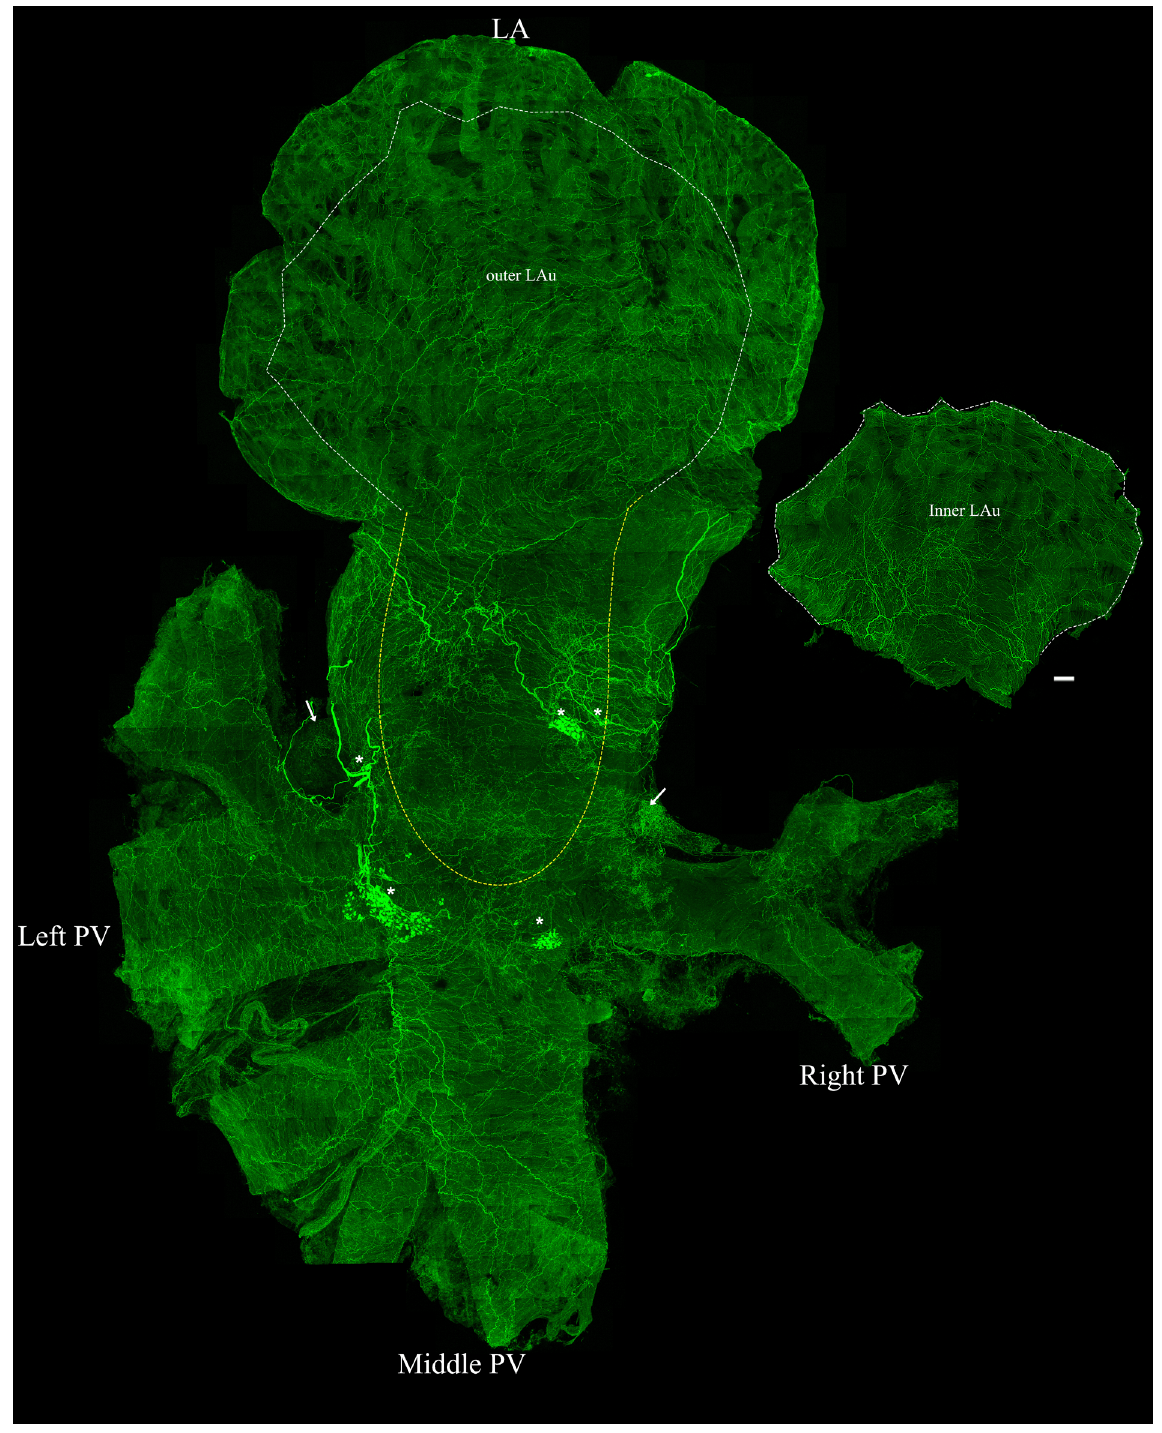
Figure 8. TH-IR axons in the LA of a representative mouse. The LA was separated from the RA of the same representative mouse in Fig. 4. A montage of ~ 700 maximal projections in the LA showed that large TH-IR bundles entered the atrium at the LA-PV junction, traveled through cardiac ganglia, branched out to smaller axon bundles and extended individual axons that innervated the whole atrium with dense terminal varicosities. (Please zoom in 400 × to view details as well as see the following figures). ICG (asterisks), fat (arrow), white dotted line (boundaries of cut to separate the sinner auricle), yellow dotted line (opening of atrium), LA-PV left atrium-pulmonary vein junction, PV pulmonary vein. Scale bar: 500